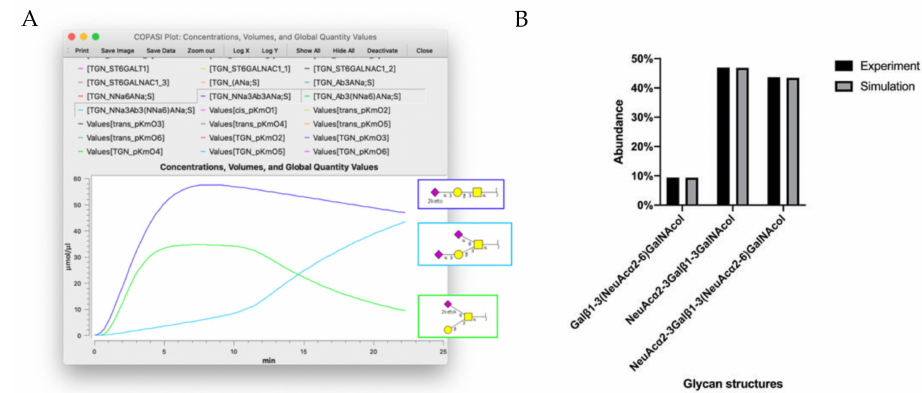
Figure 4. Simulation results of the CHO-WT cell line. ( A ) The simulation results in COPASI shows the glycan structures and their abundances in the last compartment “TGN”. ( B ) The abundance of each predicted structure at the end of the simulation compared to the concentrations measured experimentally. Structures are depicted using the Symbol Nomenclature for Glycans (NSFG) symbol nomenclature (yellow square = GalNAc, yellow circle = Gal, purple diamond = sialic acid).